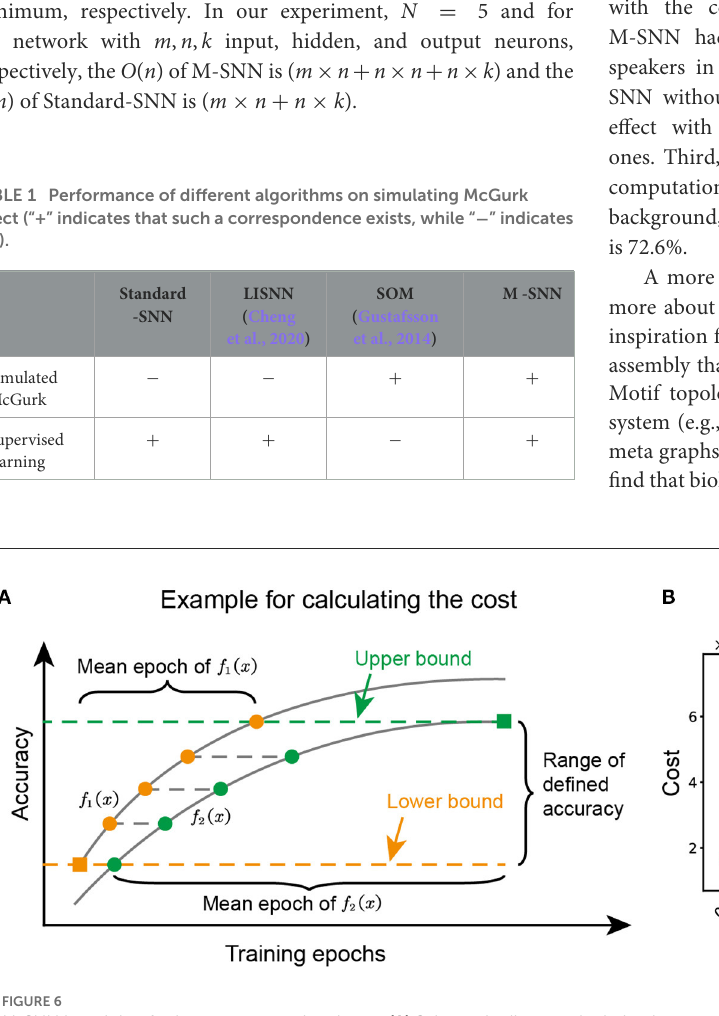
FIGURE6 M-SNN in training for lower computational cost. (A) Schematic diagram depicting how to calculate the mean epoch during training. (B) The computational cost of network training under different proportions of noise.